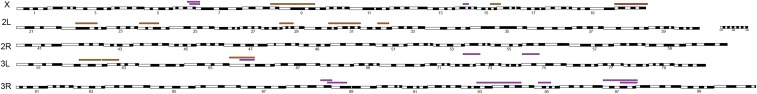
Deficiency mapping of hybrid incompatibilities in the D. simulans genome at two different temperatures. Orange: hybrid inviability only at 18°. Pink: hybrid inviability only at 24°. Red: hybrid inviability at both temperatures. Deficiencies not causing hybrid inviability are not shown.